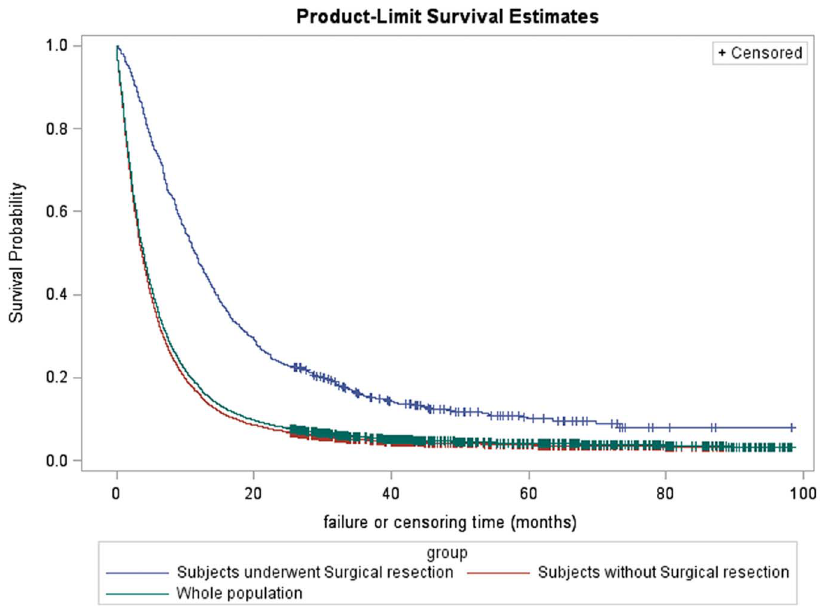
Figure 2. The survival rate of pancreatic cancer patients among Shanghai residency, Shanghai Cancer Registry 2004 – 2009. Whole population: 1-year survival rate 17.8%, 3-year survival rate 5.7%, 5-year survival rate 4.1%, Subjects underwent surgical resection: 1-year survival rate 47.5%, 3-year survival rate 15.4%, 5-year survival rate 10.1%, Subjects without surgical resection: 1-year survival rate 16%, 3-year survival rate 5.1%, 5- year survival rate 3.7%.